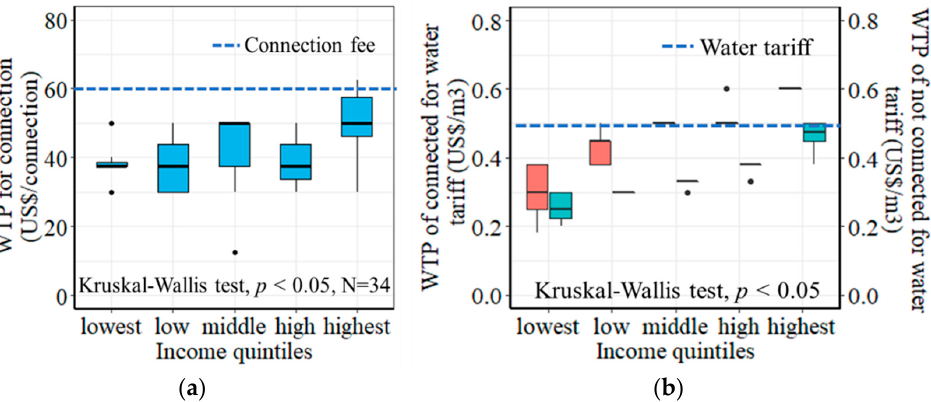
Figure 9. ( a ) Non-connected households’ WTP for connection and ( b ) WTP of connected and not- connected households for water tariffs across income quintiles (red boxes: connected households ( n = 75), green box: non-connected households ( n = 34)).